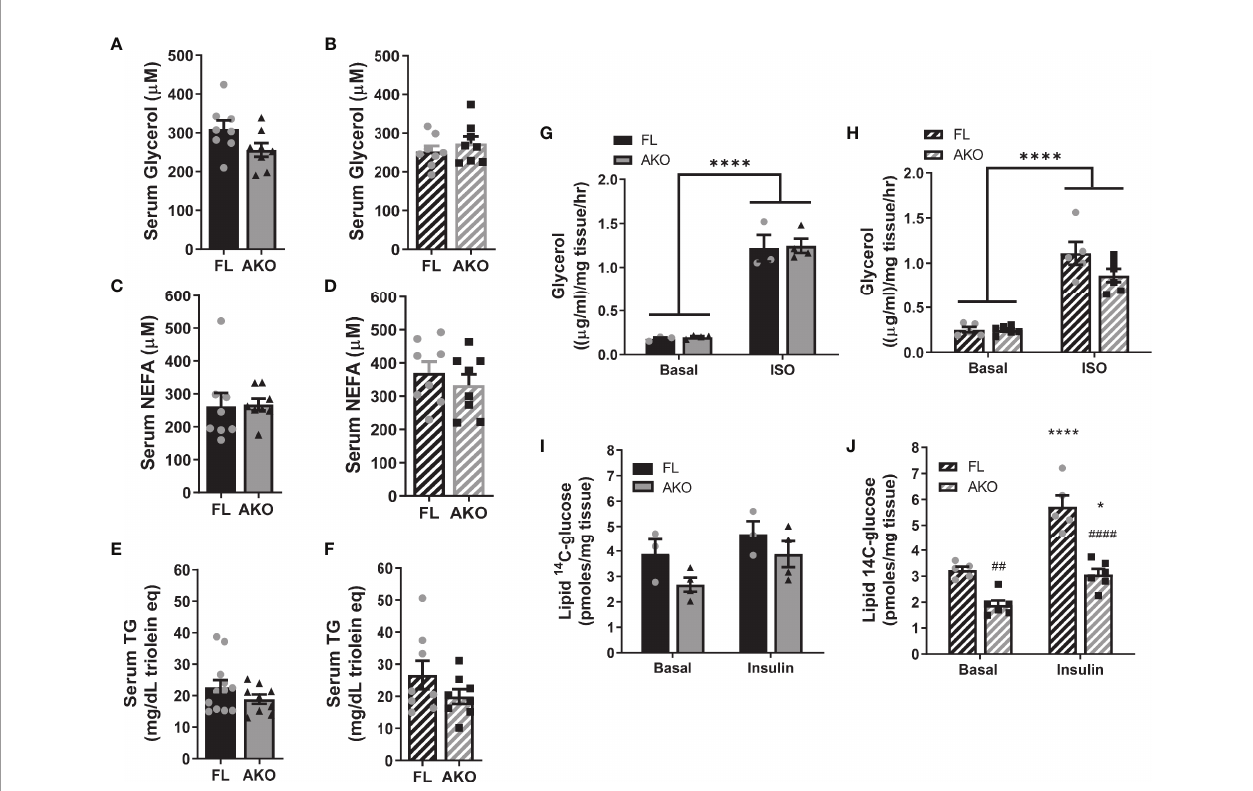
FIGURE 5 | STAT5 AKO mice do not show any differences in adipose tissue lipid metabolism relative to fl oxed control mice. Female (A, C, E, G, I) and male (B, D, F, H, J) STAT5 AKO (AKO) and fl oxed (FL) littermate control mice were fed a de fi ned-composition low-fat diet (LFD - 10% kcal from fat; A – D ) or regular chow (13% kcal from fat; E – J ). (A – D) After 1 month on LFD diet, at 3 months of age, serum glycerol and non-esteri fi ed fatty acid (NEFA) levels were measured in 4 h- fasted mice. E and F) Serum triglyceride (TG) levels were measured in 8-week-old, overnight-fasted mice. Ex vivo lipolysis (G, H) and de novo lipogenesis (I, J) assays were performed using gWAT and iWAT explants, respectively, from chow-fed mice (5 months old). (G, H) Glycerol release from gWAT explants (~20mg) into media following a 2 h-incubation period was measured under both basal and isoproterenol (ISO)-stimulated (10µM) conditions. I and J) Incorporation of 14 C- glucose into total triglycerides was measured by incubating iWAT explants (~50mg) with 4µCi/ml of [ 14 C]-U-glucose for 4.5 hours. The triglyceride (neutral lipid) fraction was puri fi ed and [ 14 C] counts were measured by scintillation counting. (A – F) t -tests were used to test for signi fi cance between means (n = 8-12 mice per genotype). (G – J) Two-way ANOVA with Tukey ’ s post-hoc multiple comparison analysis was used to test for signi fi cance between genotypes and treatments (n = 3-6 mice per group). Signi fi cance is denoted as *p < 0.05 or ****p < 0.0001 for basal versus ISO or insulin comparisons and ## p < 0.01 or #### p < 0.0001 for AKO versus FL